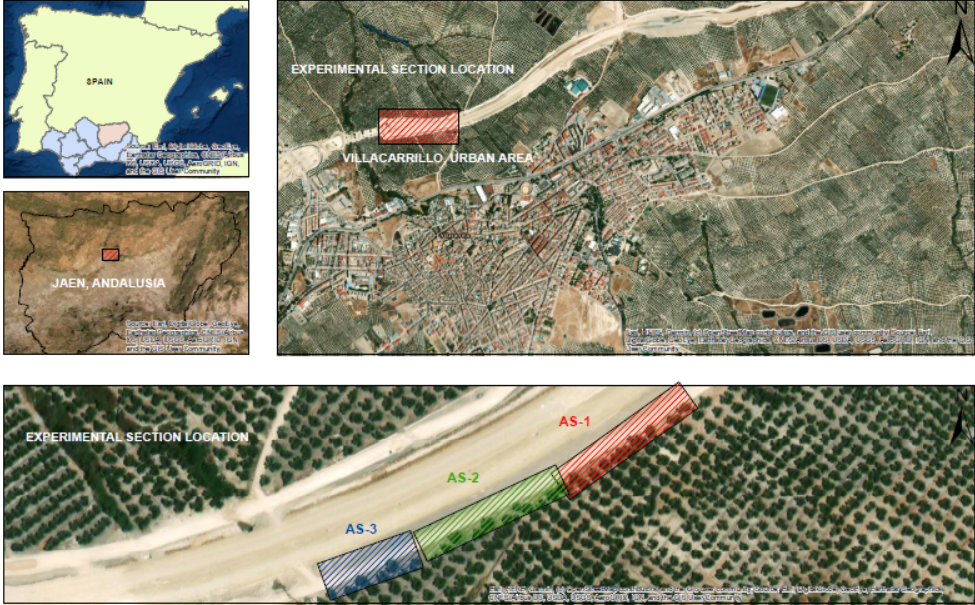
Figure 9. General location of the trial sections.